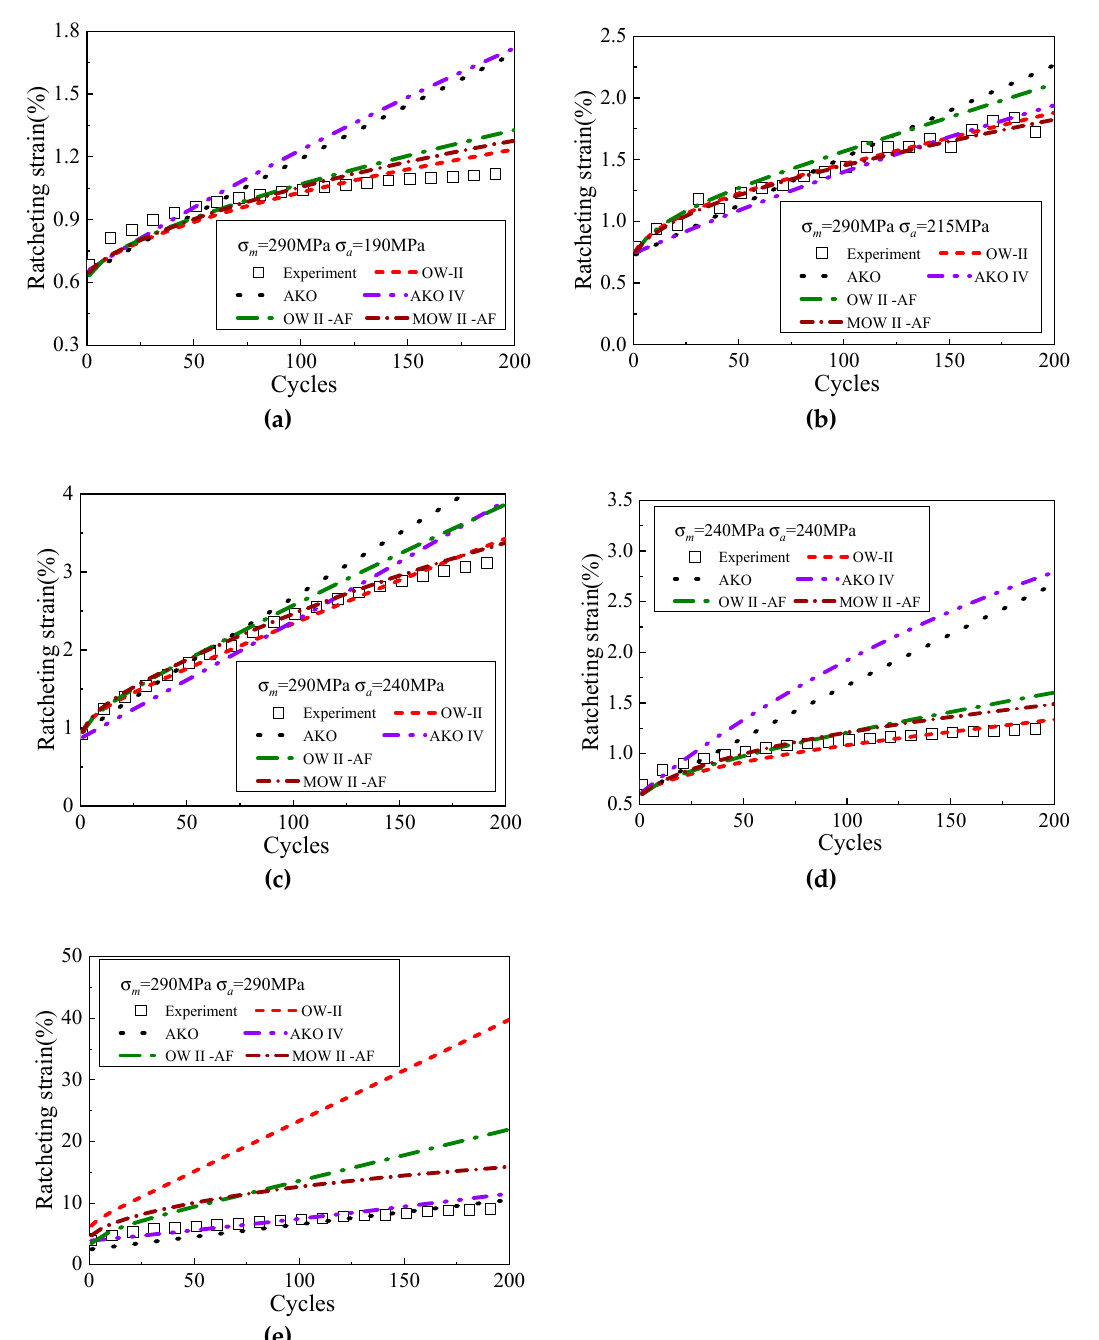
Figure 5. Ratcheting strain prediction of different loading conditions: ( a ) σ m = 290 MPa σ a = 190 MPa ( b ) σ m = 290 MPa σ a = 215 MPa ( c ) σ m = 290 MPa σ a = 240 MPa ( d ) σ m = 240 MPa σ a = 240 MPa ( e ) σ m = 290 MPa σ a = 290 MPa.